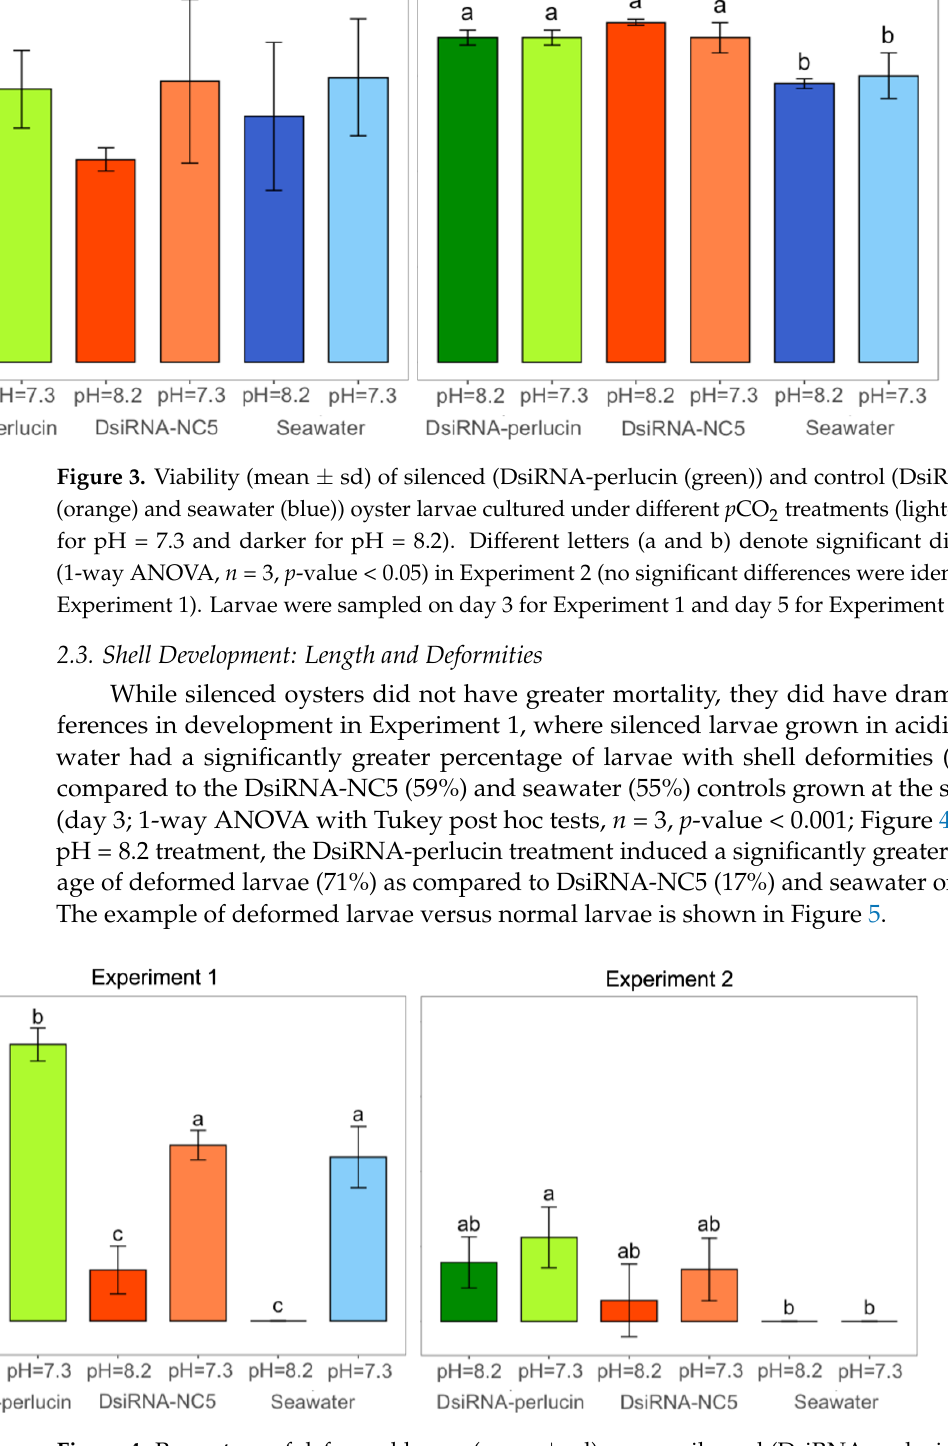
Figure 4. Percentage of deformed larvae (mean ± sd) among silenced (DsiRNA-perlucin (green)) and control (DsiRNA-NC5 (orange) and seawater (blue)) oysters cultured under different p CO 2 treatments (lighter shades for pH=7.3 and darker for pH=8.2). Different letters (a, b, and c in Experiment 1 and a and b in Experiment 2) denote significant differences between treatments within each experiment (1-way ANOVA, Tukey post hoc tests; p -value < 0.05, n = 3). Larvae were sampled on day 3 for Experiment 1 and day 5 for Experiment 2.